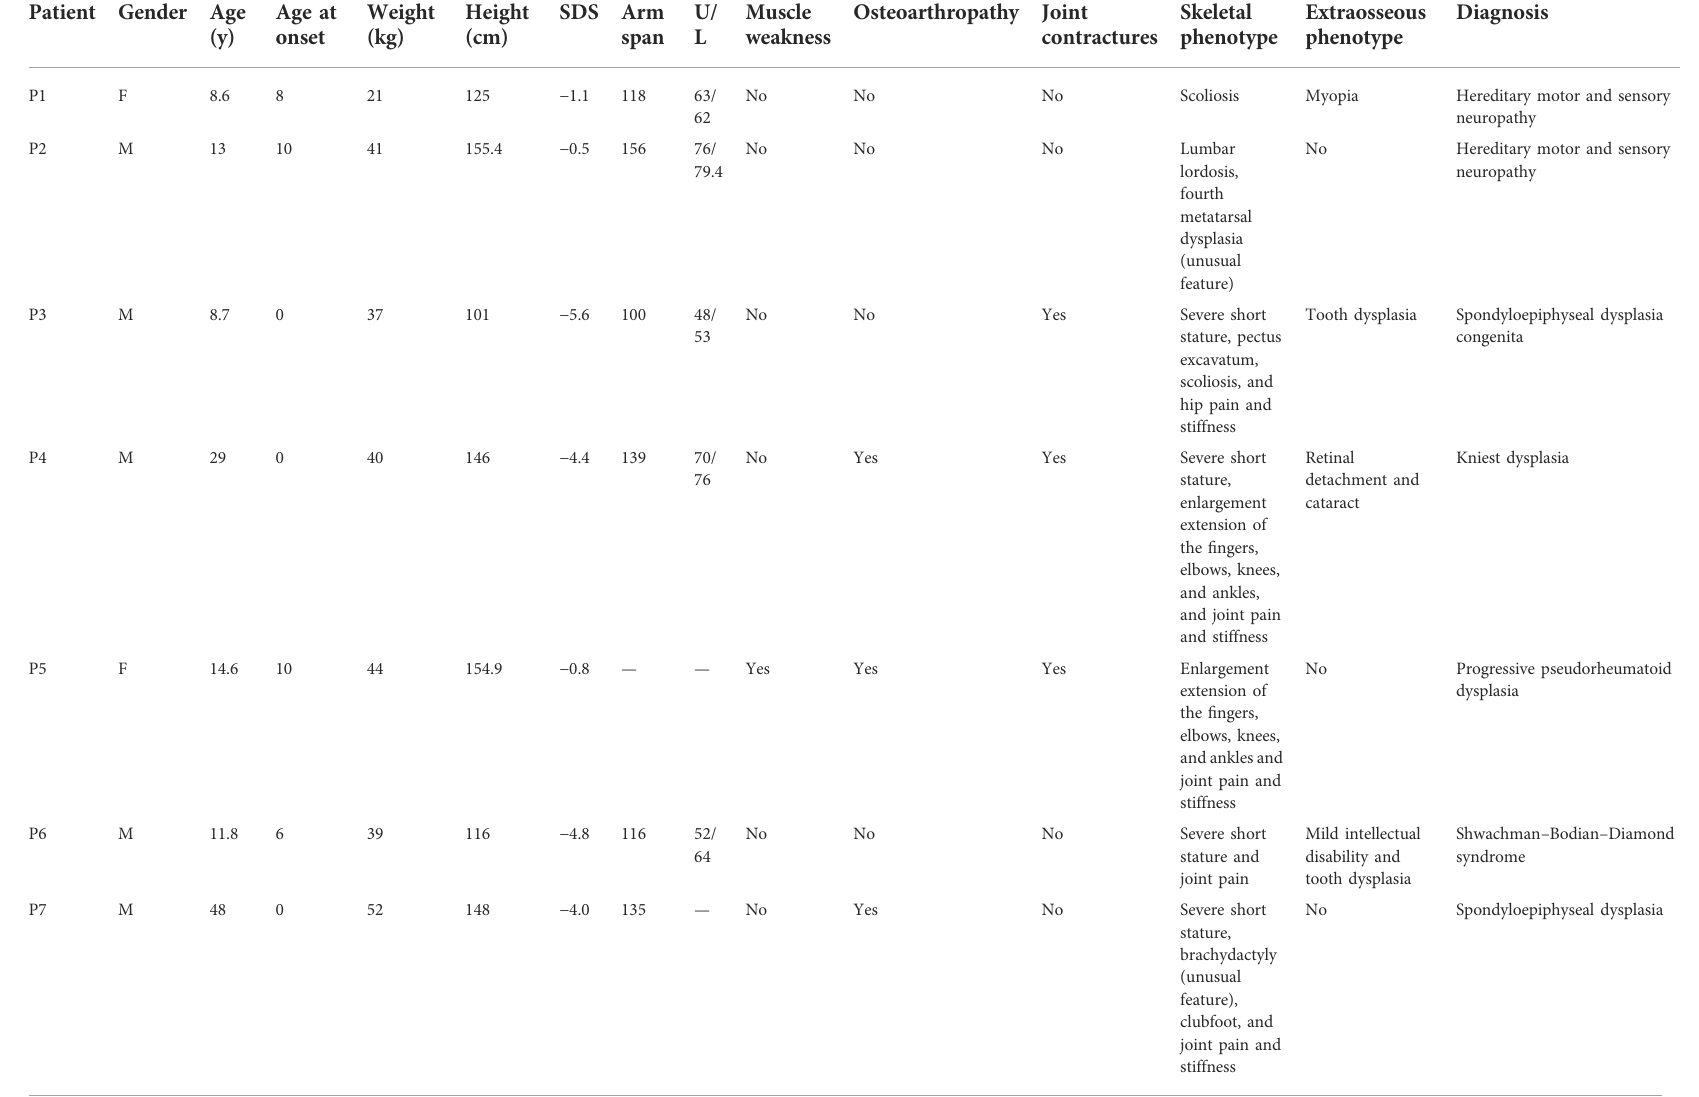
TABLE 1 Clinical characteristics of seven probands with